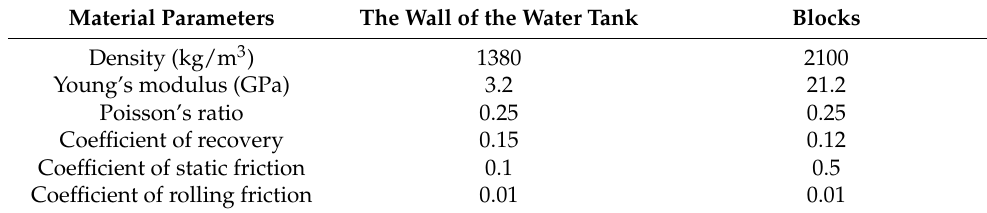
Figure 14. The test and simulation of the angle of repose. Table 3. Parameters of the EDEM model. Table 3. Parameters of the EDEM